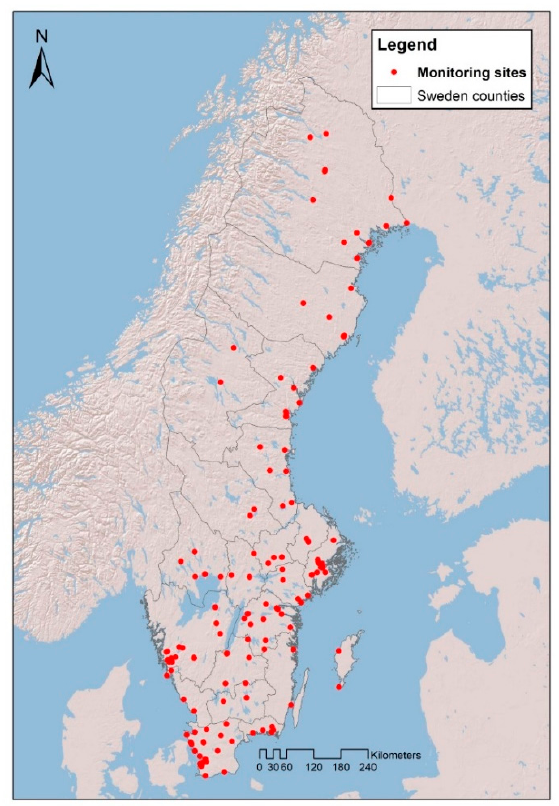
Figure 1. Spatial distribution of the monitoring stations in Sweden, years 2005–2016.